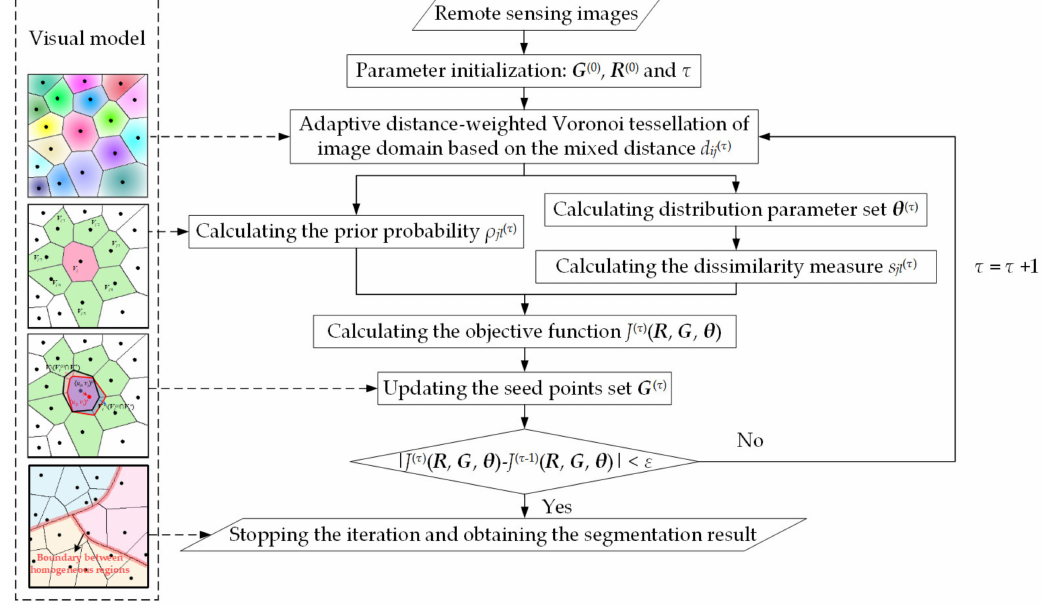
Figure 5. Flow chart of the proposed